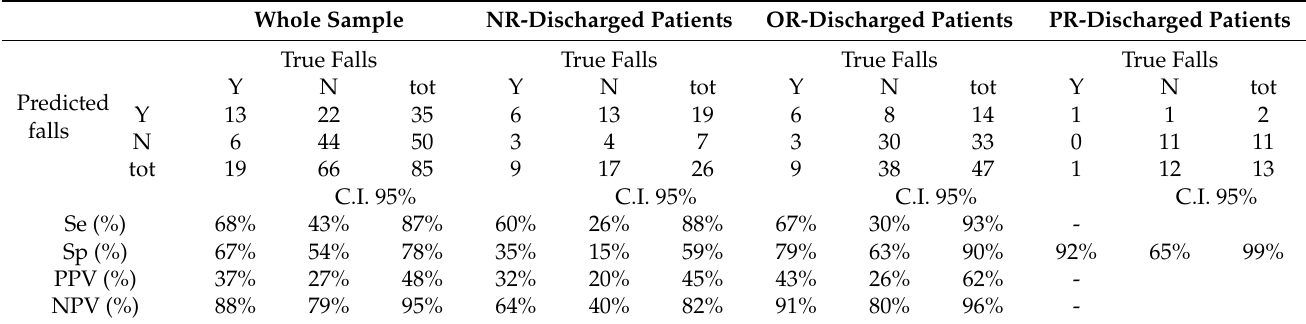
Table 5. Predictive ability of the HIIFRM administered at discharge from rehabilitation wards. Whole